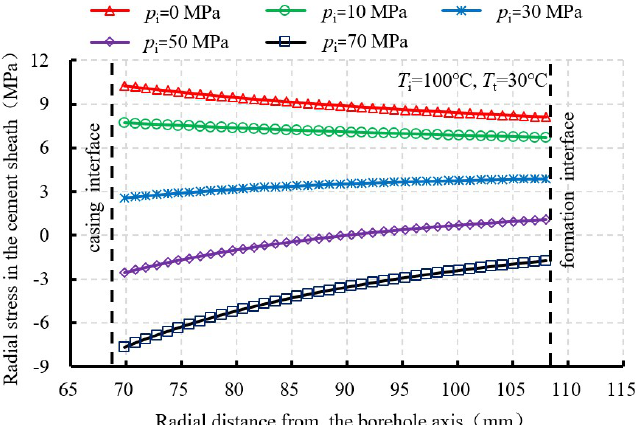
Figure 5. Radial distribution of the radial stress in the cement sheath under different increased casing pressures p i and a decreased temperature of 70 °C at the casing inner wall.